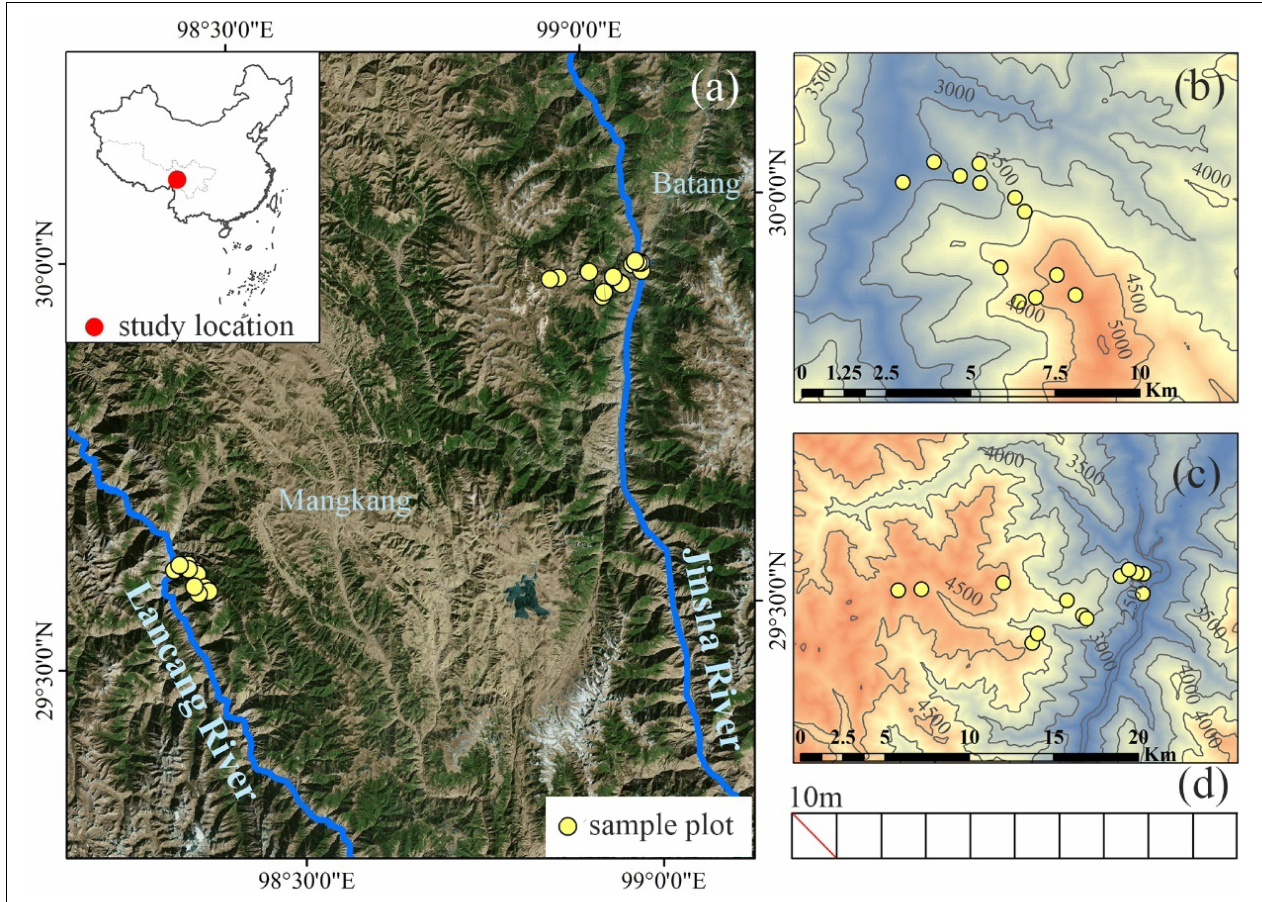
FIGURE 1 | The geographical location of the study area and sampling sites. (a) Location of the study area; (b,c) the locations of the sampling sites on the west and east slopes of Hongla Snow Mountain; (d) the setting diagram of the transects, each transect of 0.1 hm 2 is composed of ten 10 m × 10 m